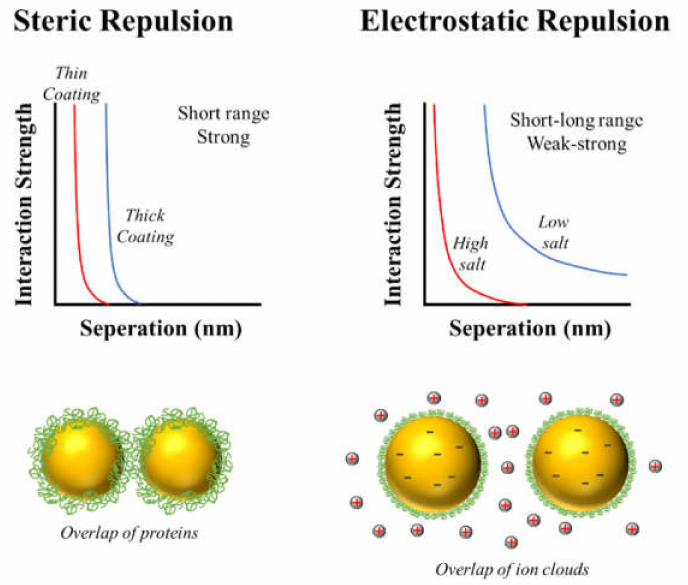
Figure 8. Protein-based emulsifiers typically stabilize oil droplets against aggregation through a combination of steric and electrostatic repulsive forces. The magnitude and range of these repulsive forces depends on the thickness, packing, and charge of the adsorbed protein